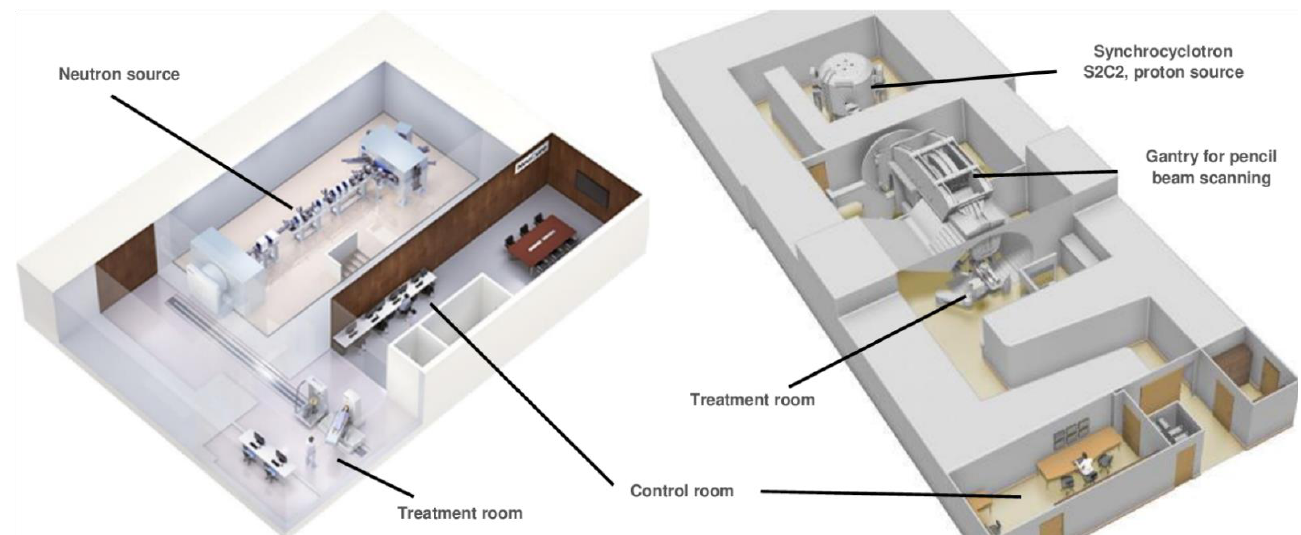
Figure 5. On the left side, the Sumitomo BNCT System NeuCure was recently approved by the Japanese government and is running in two hospitals from early 2020. Image adapted from [116]. On the right side, a compact accelerator of Proteus ® ONE protons, installed at Willis-Knighton Center in Los Angeles, USA, clinically used from 2014. Image adapted from [117].